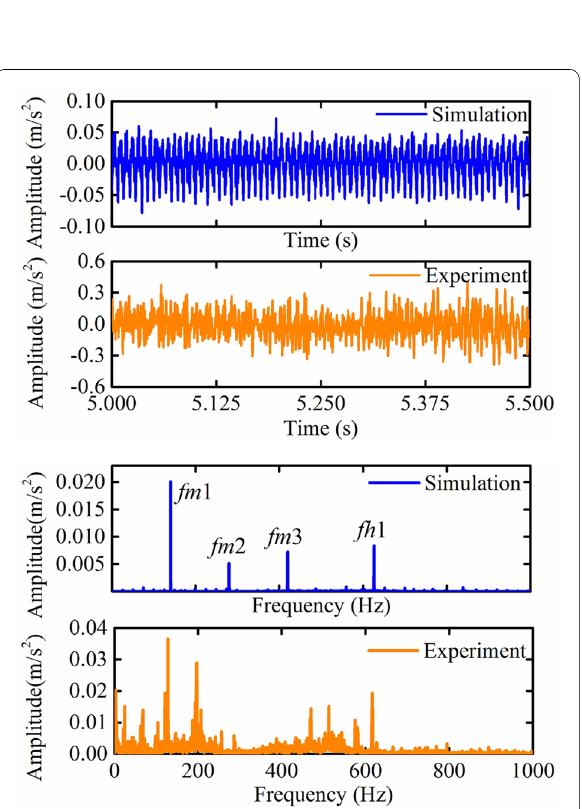
Figure 18 Vibration acceleration of main shaft in time domain and frequency